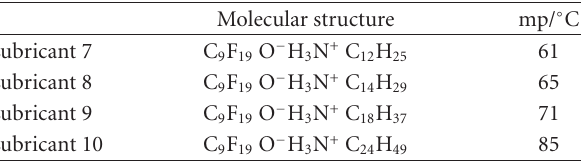
Table 3: Structure of the lubricant. Molecular